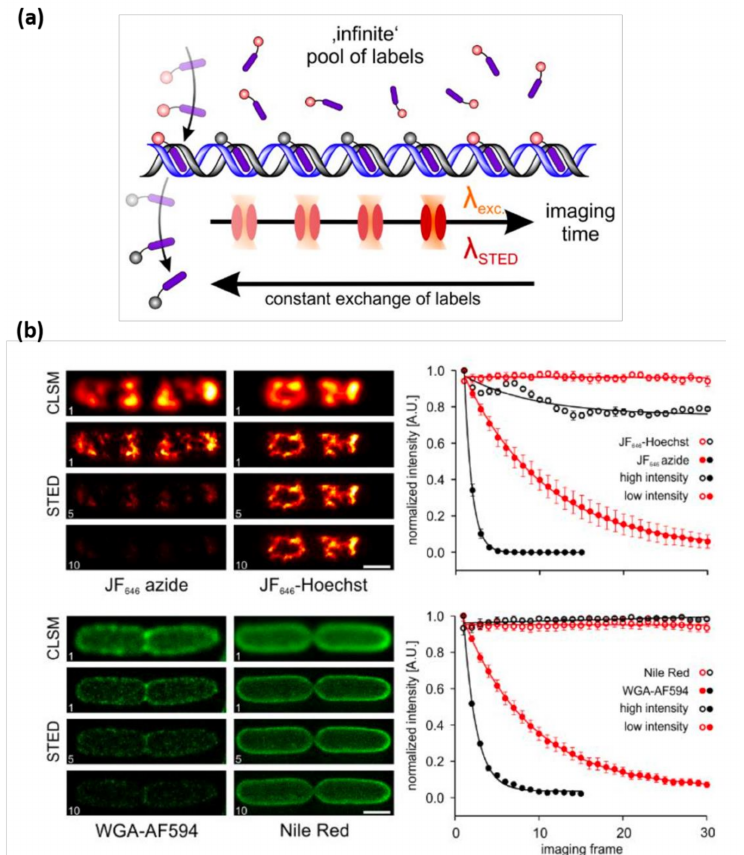
Figure 5. STED nanoscopy with exchanging probes. ( a ) Fluorophores that dynamically bind and unbind from their target structure ensure a constant exchange and allow long-term STED imaging. ( b ) Repeatedly acquired STED nanoscopy images using regular and reversibly binding labels target- ing the E. coli membrane or nucleoid. Cells were labeled with immobile (left images) or exchanging probes (right images). A high concentration of the exchangeable dyes JF 646 -Hoechst and Nile Red was applied for the dynamic labeling of DNA (red) and E. coli membranes (green), respectively. Graphs on the right show intensity time trace of regular STED image, using exchanging probes at high and low STED laser intensities. Reprinted (adapted) with permission from